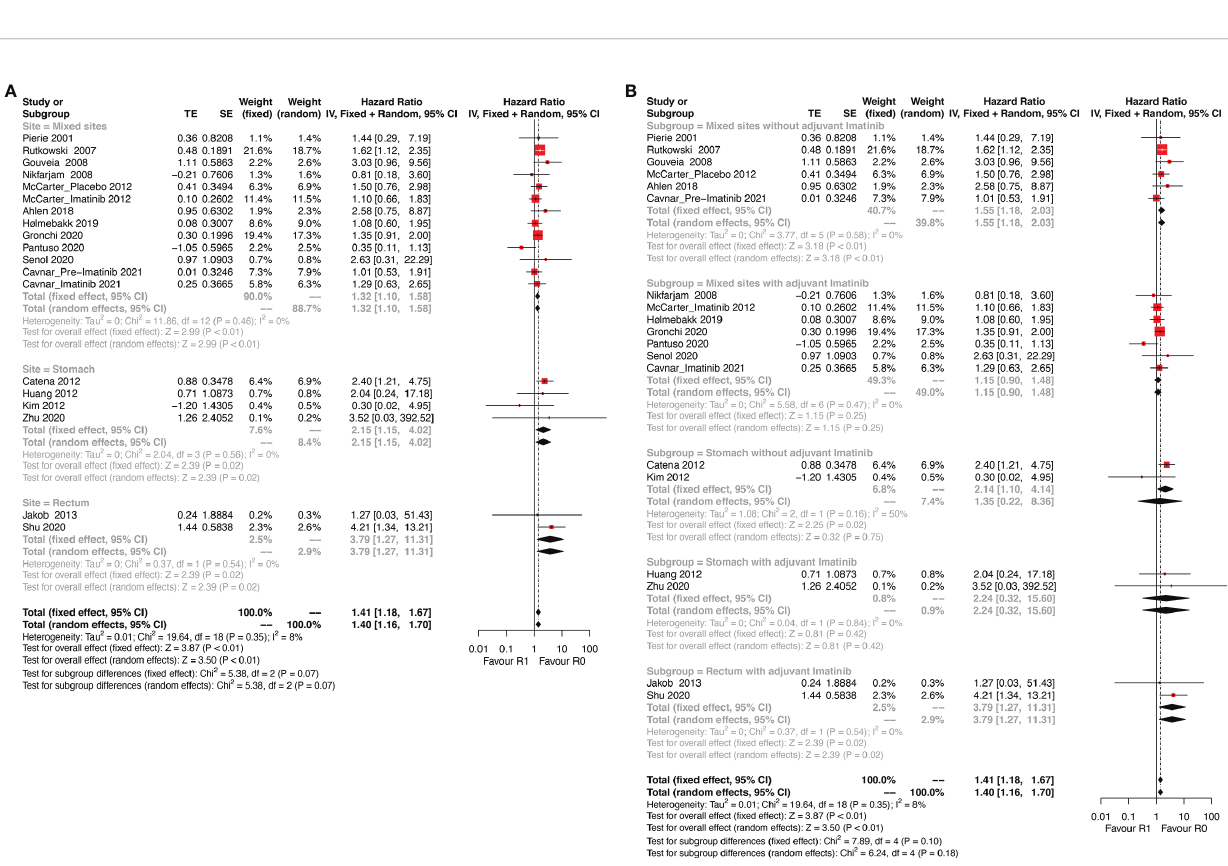
FIGURE 3 | Forest plots illustrating disease-free survival between R1 and R0 margins. Subgroup analysis according to (A) tumor site and (B) combination of tumor site and use of adjuvant Imatinib.